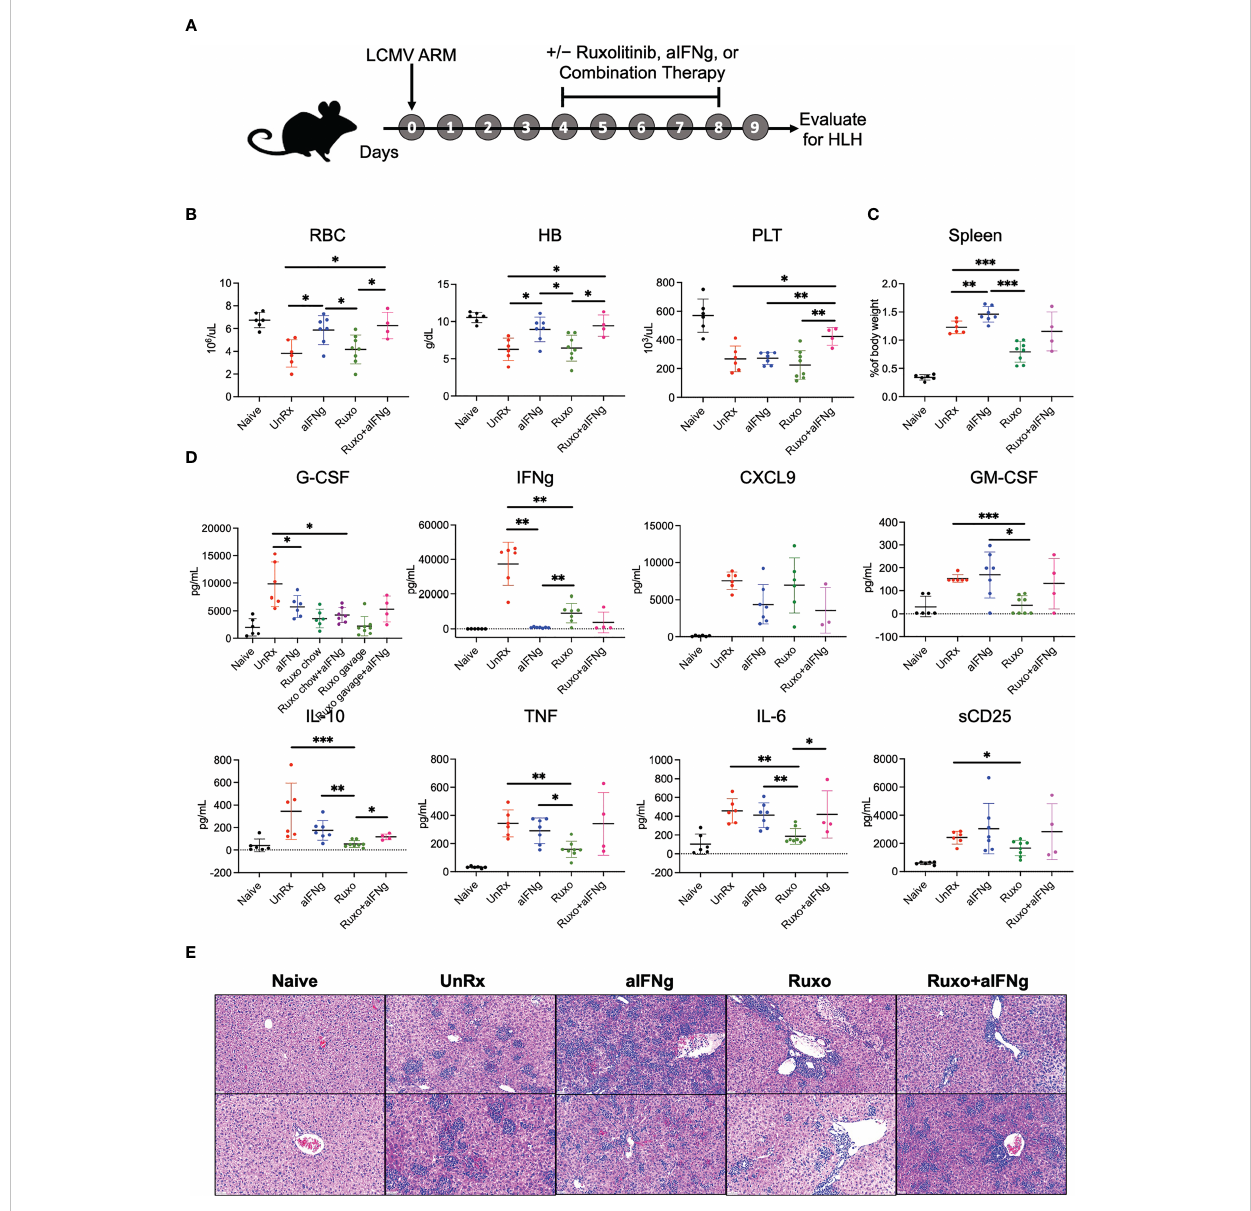
FIGURE 2 aIFNg, ruxolitinib, and combination treatment of Prf1 − / − mice infected with LCMV Armstrong. (A) Schematic representation of the experiment; Prf1 − / − mice infected with LCMV Armstrong (LCMV ARM) and treated with IFNg neutralizing antibody (aIFNg), ruxolitinib, or a combination of both agents (as described in the Methods) starting day 4 and continuing until day 8 p.i. Mice were then euthanized and multiple HLH parameters were evaluated on day 9 p.i. Naïve mice served as a negative control. (B) Number of red blood cells (RBC) (10 6 / m L), hemoglobin (HB) concentration (g/dL) and number of platelets (PLT) (10 3 / m L) in the various mouse cohorts. (C) Spleen weights depicted as a proportion of the fi nal body weight. (D) Concentration of serum cytokines in the blood. Data points were pooled from two experiments and each data point represents one mouse. Outliers were removed using Grubb ’ s test (E) Representative images of hematoxylin and eosin-stained liver sections shown at a magni fi cation of 20X; Each sample represents one liver section from one mouse. Sections from histological analysis were randomly chosen in a blinded fashion for inclusion in the Figure. * P < 0.05, ** P < 0.01, *** P <